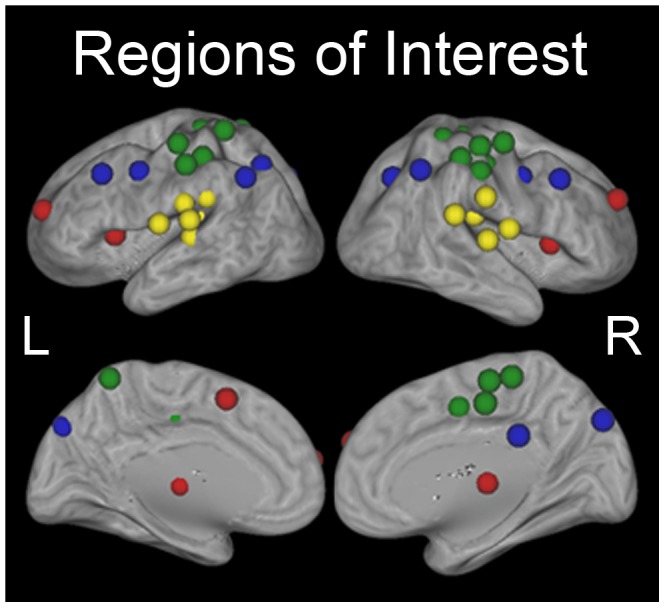
The 49 intrinsic regions of interest (ROIs) utilized in this study.ROIs were defined from two cognitive control networks [7] and two non-cognitive control networks [25]. Red spheres (7) are regions of the cingulo-opercular (CO) network, blue spheres (11) are regions of the fronto-parietal (FP) network, green spheres (18) are regions of the hand somatosensory-motor (SM) network, and yellow spheres (13) are regions of the auditory (AU) network.